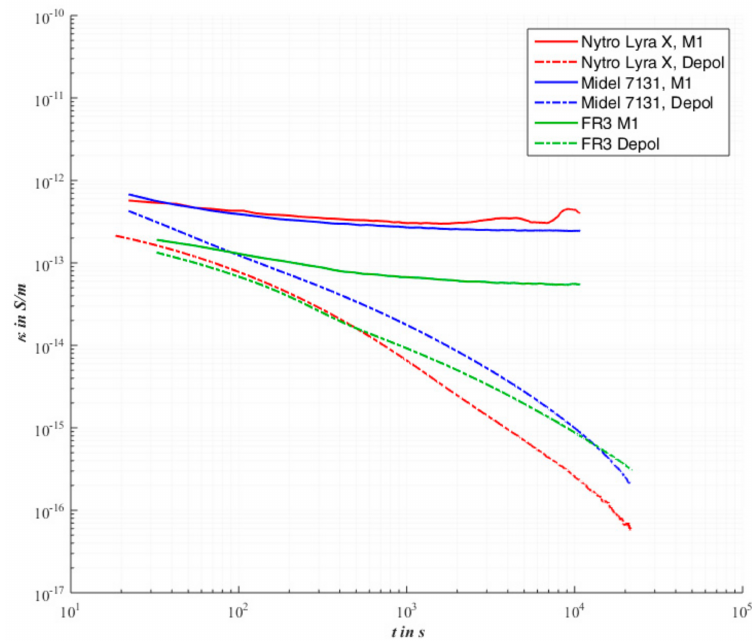
Figure 5. Pristine pressboard barrier system